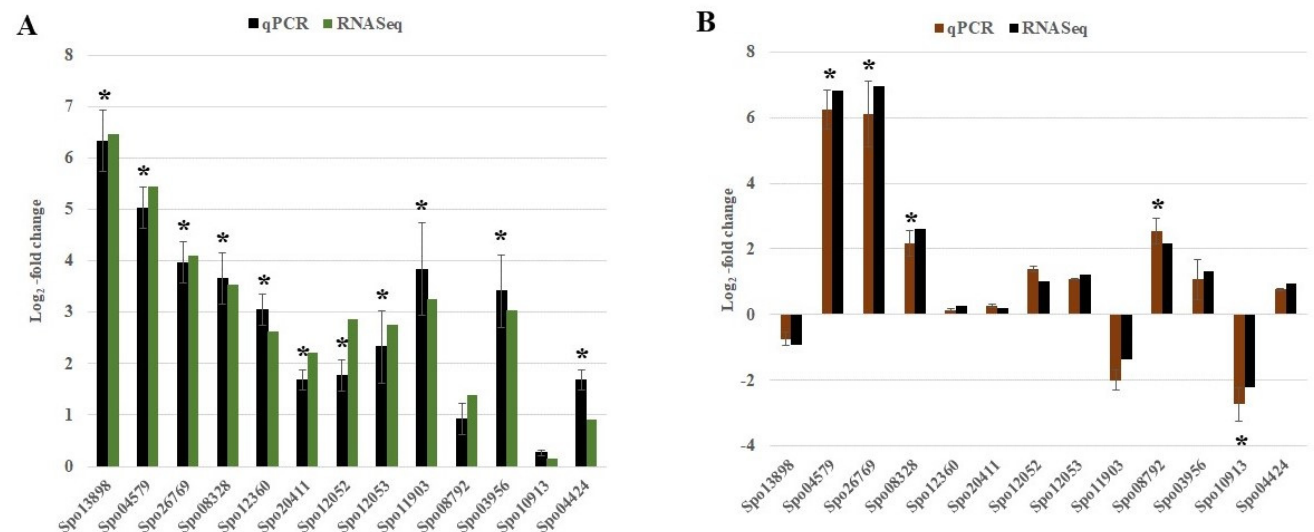
Figure 7. Fold changes (Log2) in the gene expression by qPCR and RNA-Seq analysis. Fold change (Log2) in the expression profiles of selected genes (including genes involved in the oxalate pathway) in ( A ) leaf and ( B ) root tissues of PI 175311. The error bars are the mean ± SE ( n = 3); asterisks (*) represent significant differences between genotypes ( p < 0.05) for qPCR analysis.